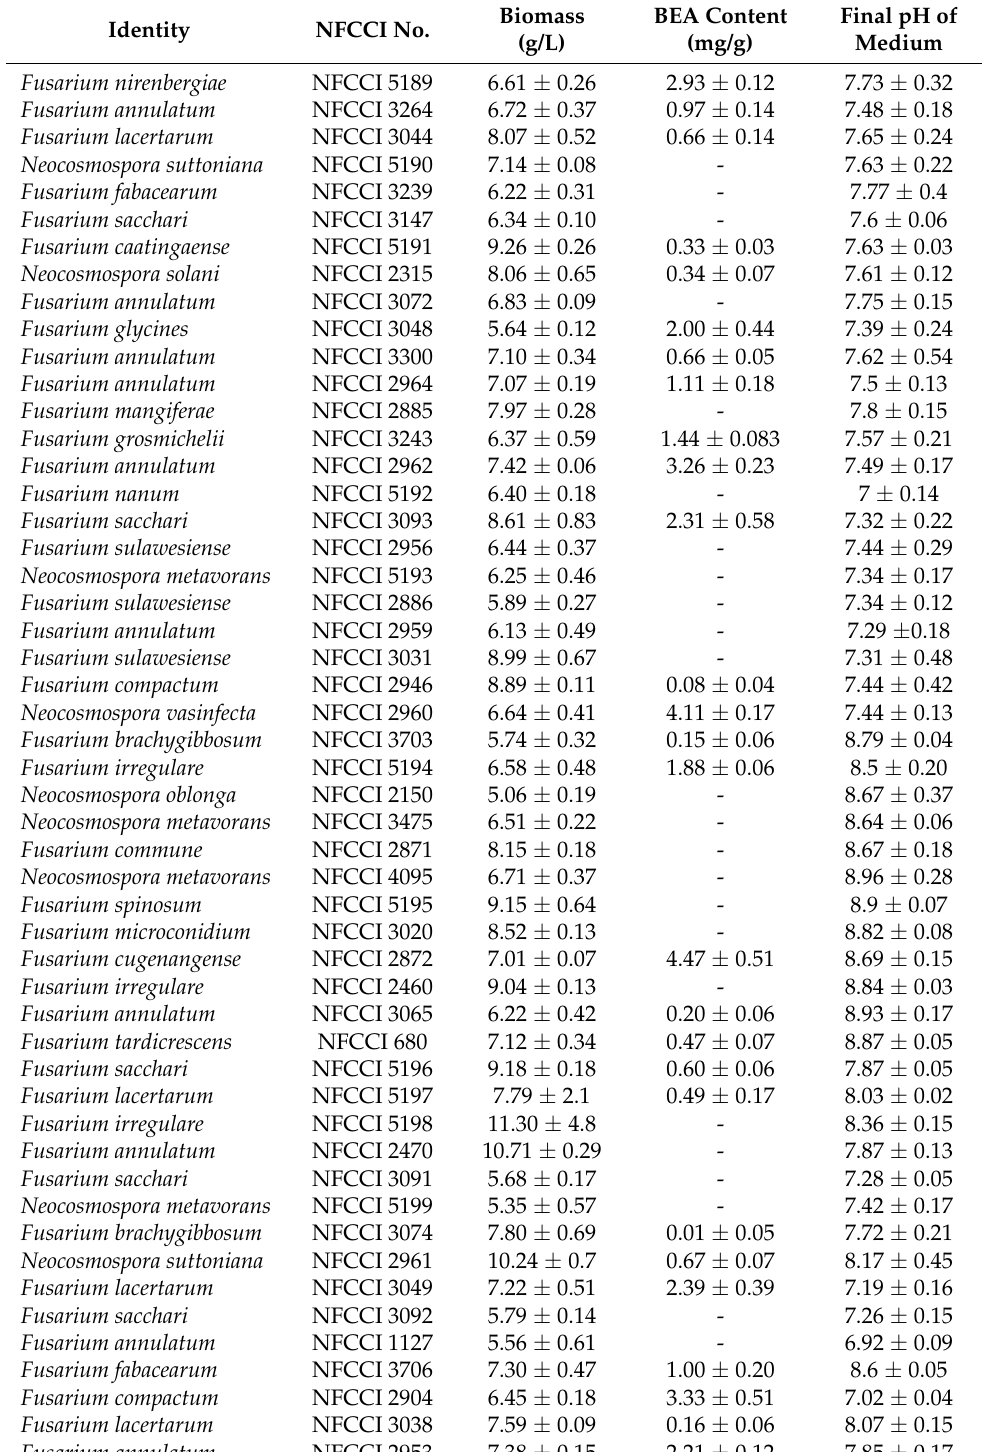
Table 5. Mycelial biomass and BEA content of Fusarium isolates and their pH in the Fusarium defined medium (on day